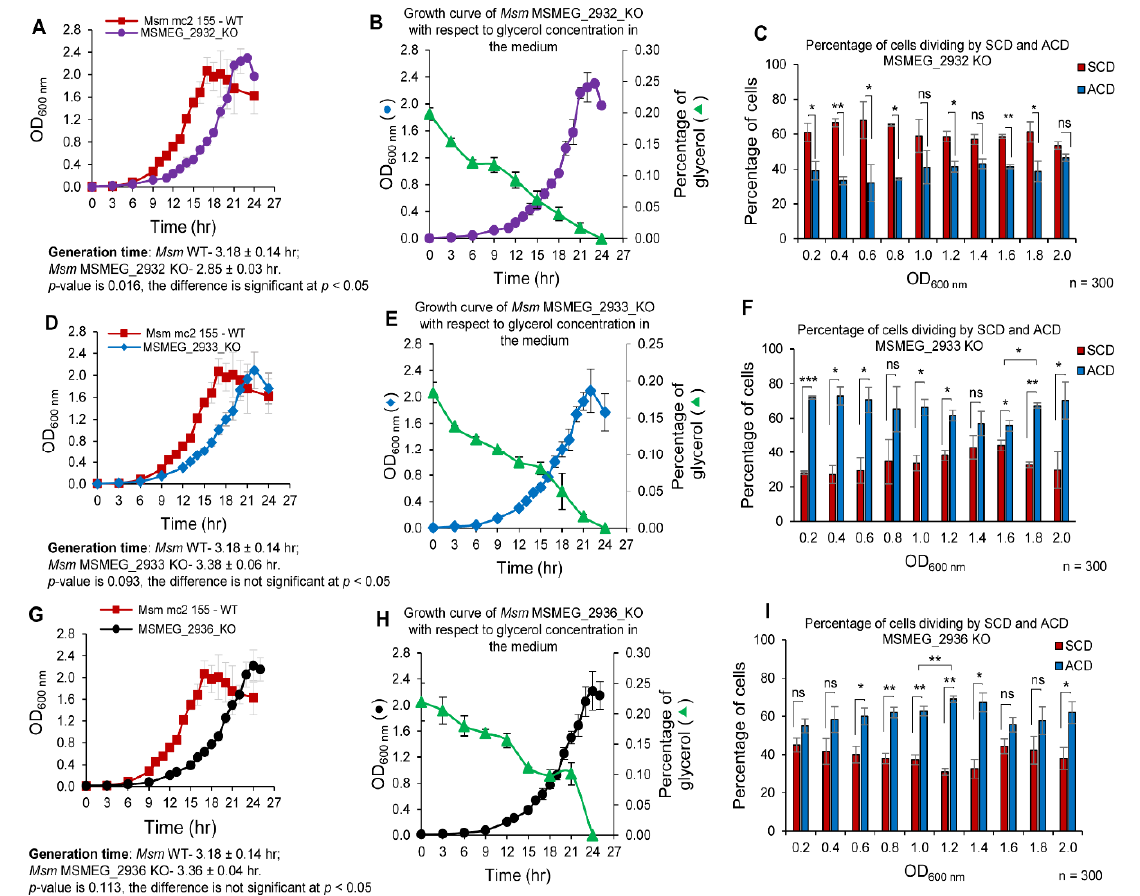
Figure 7. Growth profiles of MSMEG_2932 KO, MSMEG_2933 KO, and MSMEG_2936 KO strains, in comparison to that of Msm WT, with respect to glycerol levels in the medium, and the proportion of the cells undergoing ACD/SCD. ( A ) Growth curve of Msm WT ( ), and MSMEG_2932 KO ( ● ). ( B ) Growth curve of MSMEG_2932 KO ( ● ) with respect to the free glycerol levels in the medium ( ). ( C ) Bar graph for the percentage of cells dividing by SCD (red bar) and ACD (blue bar) of Msm MSMEG_2932 KO at different OD 600 nm values. ( D ) Growth curve of Msm WT ( ) and MSMEG_2933 KO ( ). ( E ) Growth curve of MSMEG_2932 KO ( ) with respect to the free glycerol levels in the medium ( ). ( F ) Bar graph for the percentage of cells dividing by SCD (red bar) and ACD (blue bar) of Msm MSMEG_2933 KO at different OD 600 nm values. ( G ) Growth curve of Msm WT ( ) and MSMEG_2936 KO ( ● ). ( H ) Growth curve of MSMEG_2936 KO ( ● ) with respect to the free glycerol levels in the medium ( ). ( I ) Bar graph for the percentage of cells dividing by SCD (red bar) and ACD (blue bar) of Msm MSMEG_2936 KO at different OD 600 nm values. The data shown are from biological triplicates and represented with mean values ± s.d. ( p < 0.05 *, p < 0.01 **, p < 0.001 ***, ns—no significance via two-tailed t -test).